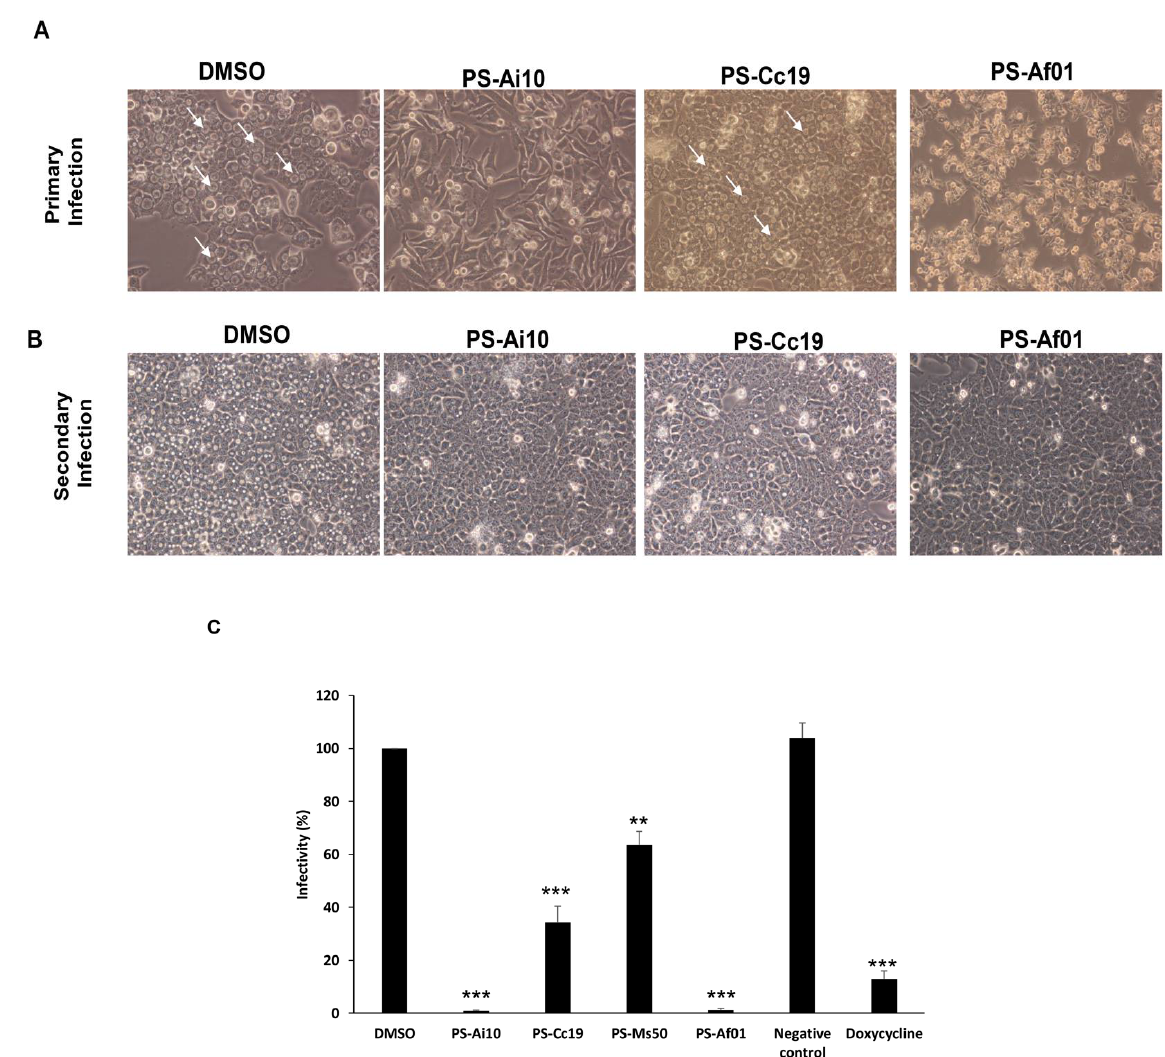
Figure 1. HeLa 229 cells were infected with C. trachomatis (MOI 0.5) and treated 2 hpi with different plant extracts (10 µg/mL), DMSO, doxycycline (10 µg/mL) (positive control) or left without treatment as a negative control. Cells were incubated in the presence of different natural compounds for an additional 46 h. ( A ) Bright field micrographs of HeLa cells infected with C. trachomatis after 48 h (primary infection). Natural compound treatment resulted in a small number of detectable small inclusions (arrows) in C. trachomatis -infected cells only in comparison with DMSO. Images taken using the same magnification. ( B ) Influence of different plant extracts on development of infectious progeny. Bright field micrographs of HeLa cells infected with cell lysates ( A ) after 24 h (secondary infection). The yield of C. trachomatis infectious progeny decreased considerably upon treatment of different plant extracts. ( C ) Infectivity percentage calculated as follows: IFU/mL estimated for each treated monolayer/IFU/mL of control cells × 100. Infectivity expressed as a percentage of control cells ± standard deviation (SD) from three independent experiments ( n = 3). ** p < 0.01, *** p <